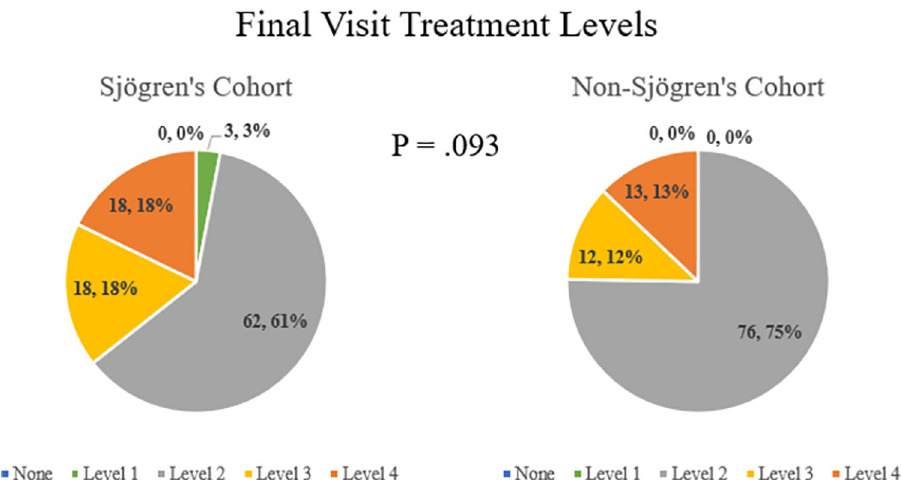
Fig 2. Final treatment levels according to tear film & ocular surface society treatment level classification for a longitudinal, tertiary clinic-based sample of patients with Sjogren’s and non-Sjogren’s dry eye disease (n = 202).